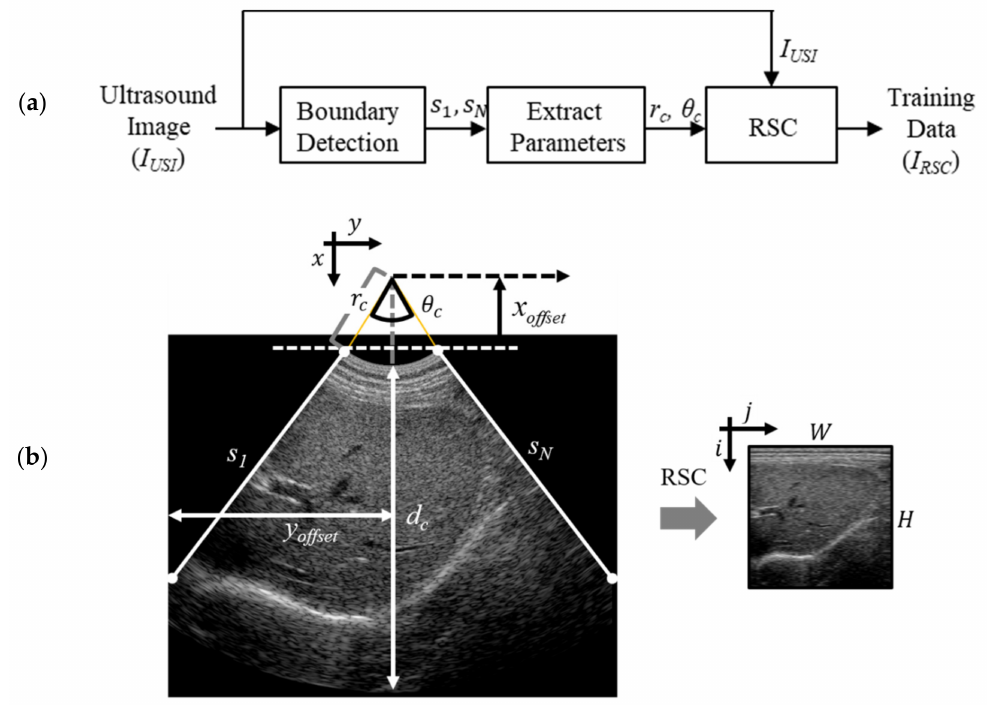
Figure 4. ( a ) Pre-processing procedure for the training data in the ultrasound dataset. r c and θ c are extracted from lines s 1 and s N . ( b ) Coordinate transforming a scan-converted image ( I USI ) to RSC image ( I RSC ). Left boundary, first scanline, between FOV and black region, is called s 1 , whereas the right boundary, last scanline, is referred to as s N . i and j are coordinate axes in I RSC . I USI has x and y coordinate